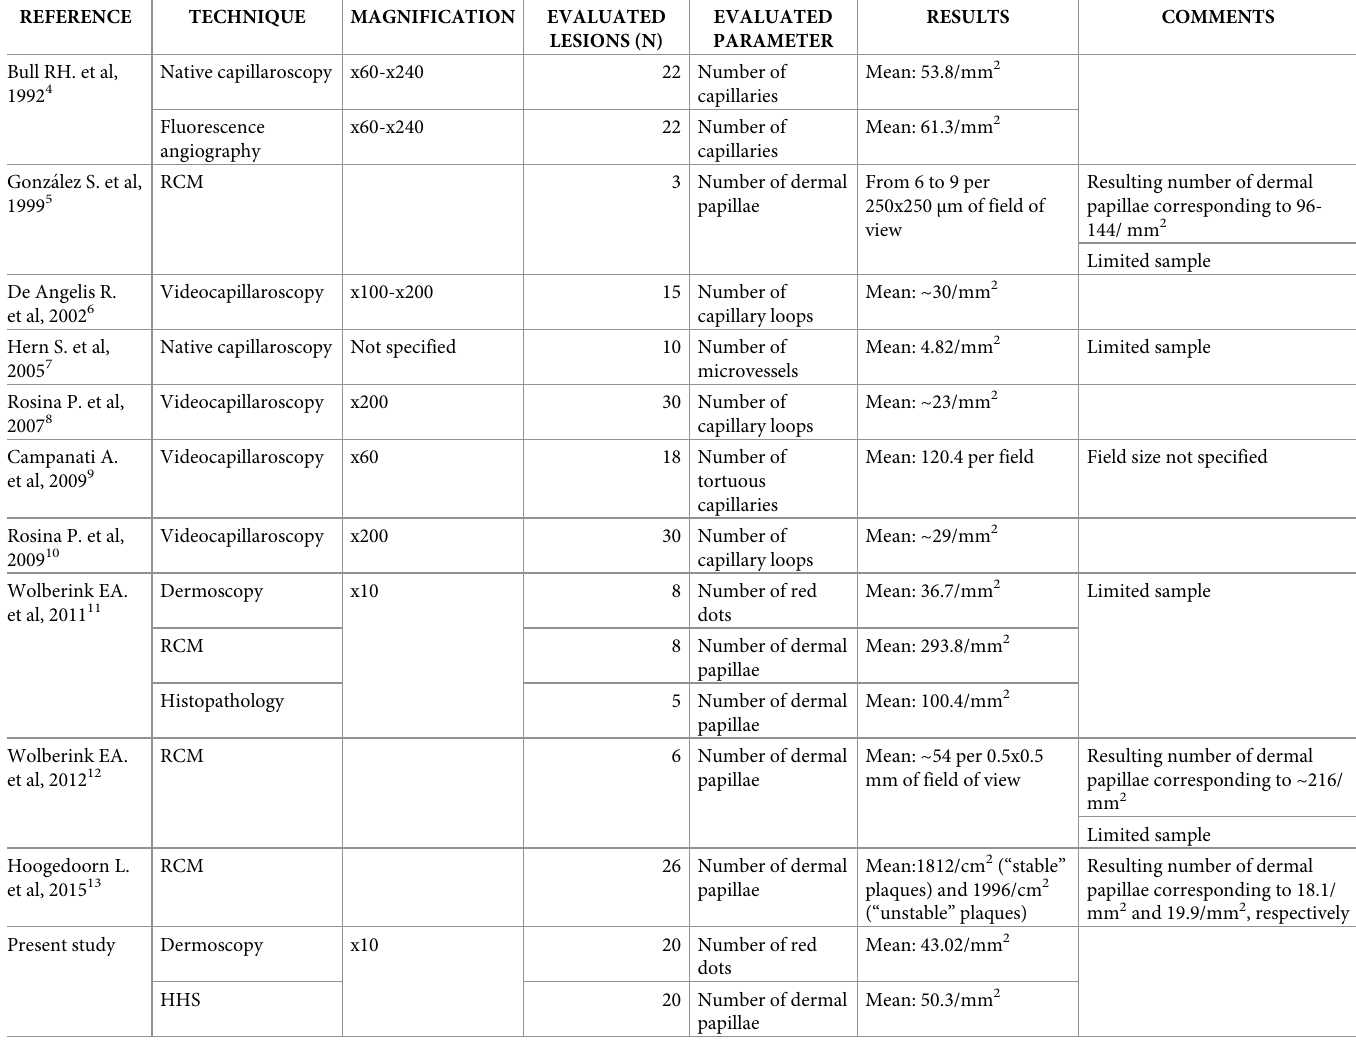
Table 2. Studies evaluating capillary density in